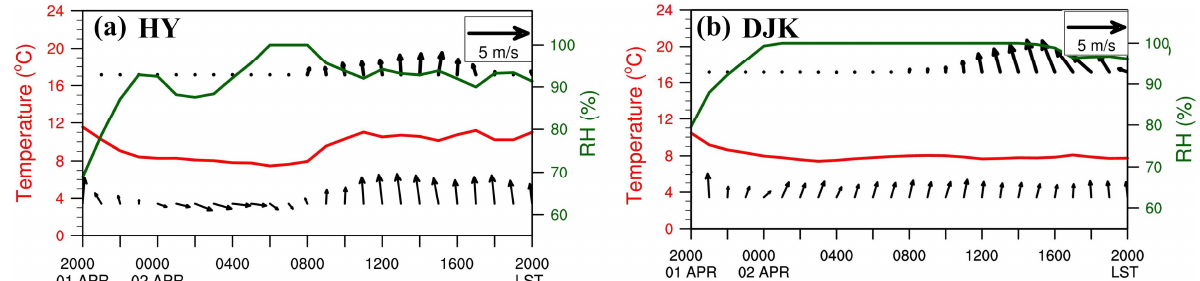
Figure 9. Simulated 2-m temperature (red line), 2-m RH (green line), and 10-m wind (thin vector) of Exp-SB0 at the two stations HY ( a ) and DJK ( b ). Upper vectors are the Exp-Ctrl minus Exp-SB0 10-m winds. See the definition of wind direction in Figure 4.